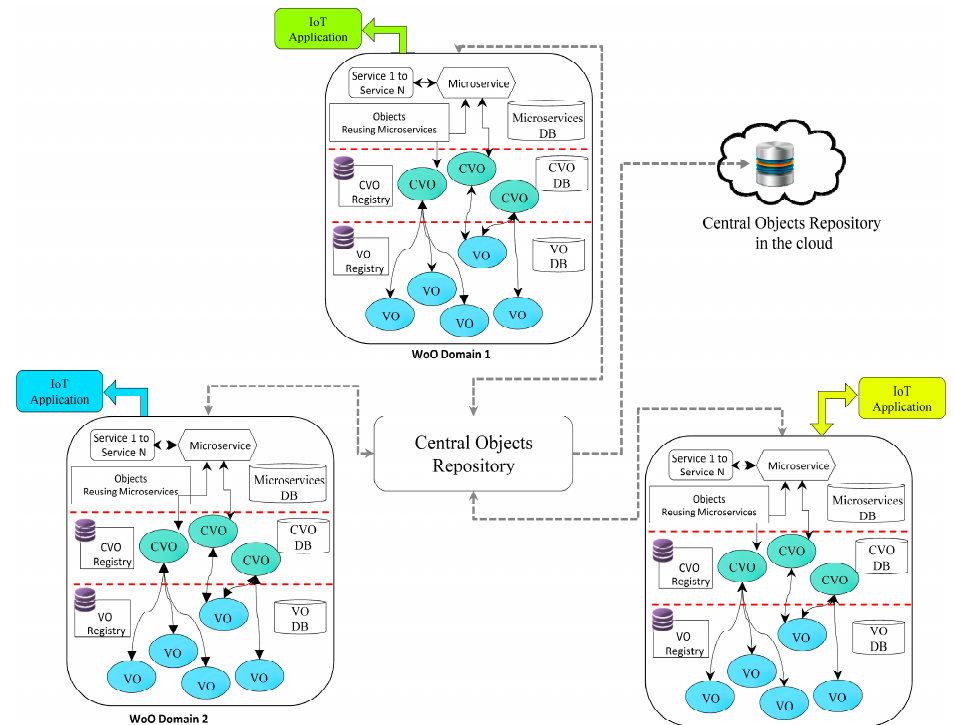
Figure 4. Objects reusability and extensibility in WoO enabled IoT environment.